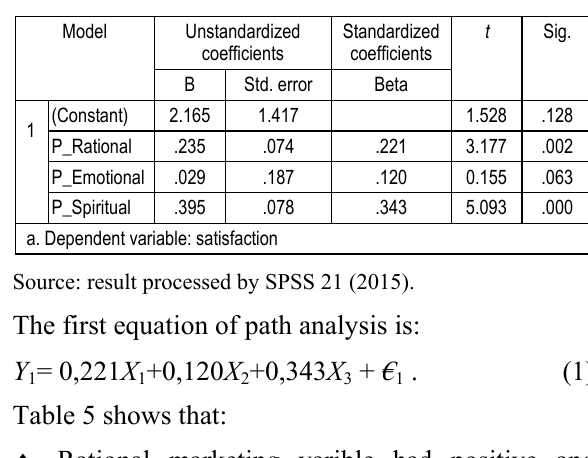
Table 5. Partial test of the first